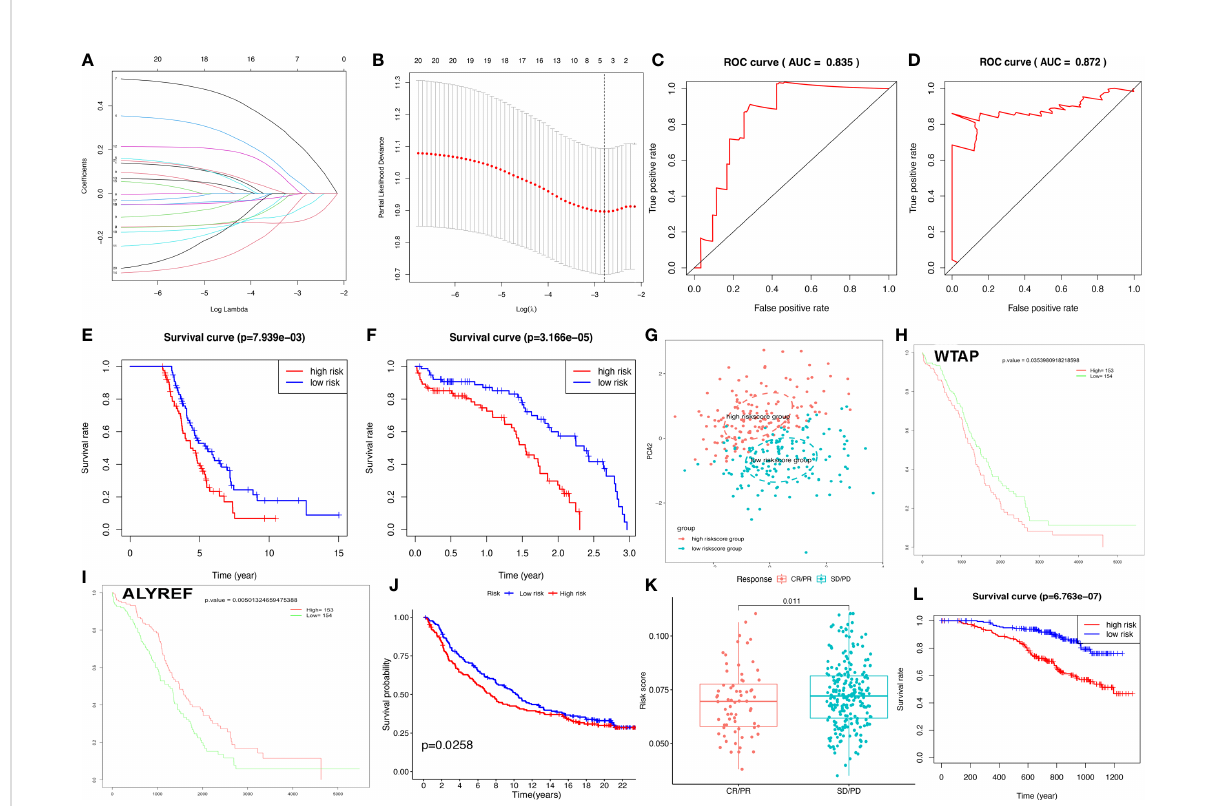
FIGURE 5 Construction of riskscore model based on four DERRGs. (A, B) . Lasso regression identi fi ed the prognostic model in ovarian cancer. (C) ROC analysis between high- and low-riskscore groups in training group. (D) ROC analysis between high- and low-riskscore groups in test group. (E) OS analysis between high- and low-riskscore groups in training group. (F) OS analysis between high- and low-riskscore groups in test group. (G) PCA analysis between high- and low-riskscore groups in ovarian cancer. (H) OS analysis of WTAP. (I) OS analysis of ALYREF. (J) OS analysis between high- and low-riskscore groups in imvigor210 cohort. (K) The response for immunethreapy based on imvigor210 cohort showed stable disease (SD), progressive disease (PD), complete response (CR), and partial response (PR). (L) . OS analysis between high- and low-riskscore groups in GSE140082